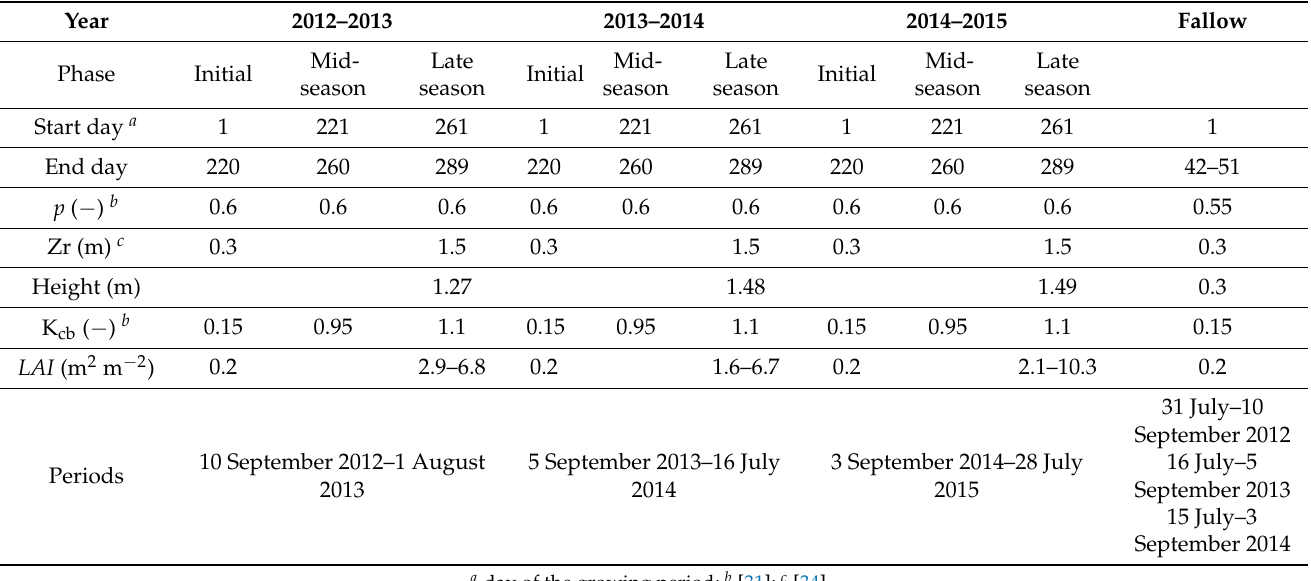
Table 2. Plant-specific parameters for crop-related modeling (p: evapotranspiration depletion factor, Zr: effective rooting depth, K cb : basal crop coefficient, LAI: leaf area